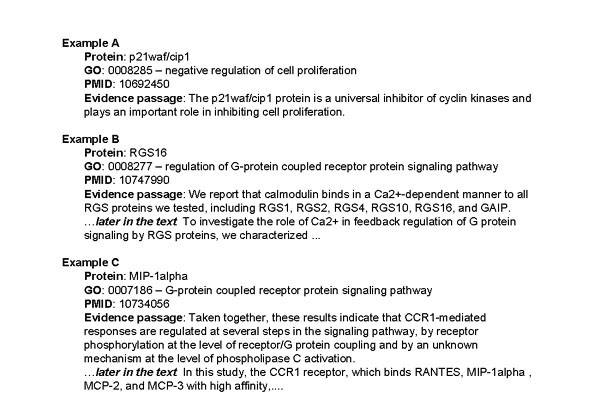
SWISS-PROT ID, GO code, PubMed ID triple and the corresponding evidence passage from the article (3 examples).